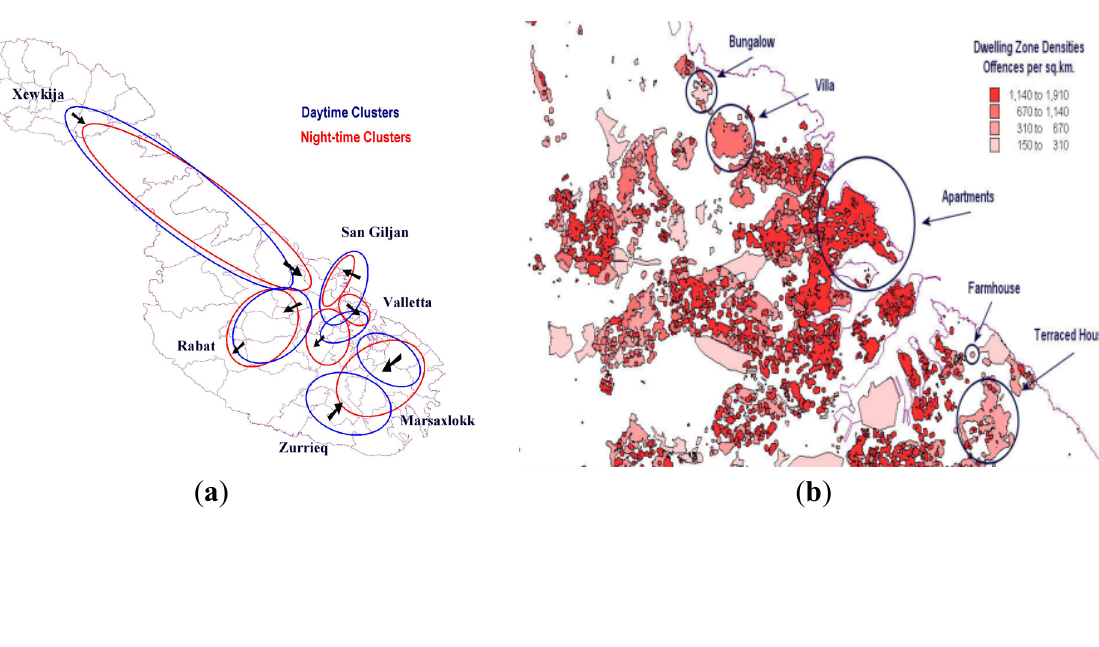
Figure 1. Spatial outputs from the CRISOLA model research ( a ) K-Means clustering by day (blue)-night(red) periods; ( b ) Offence Densities by Dwelling Type (dark higher rates); ( c ) NNH Offence Hotspots (red high-blue low); ( d ) NNH1 Poverty (social) ellipsoids (green) and Offender residence (blue